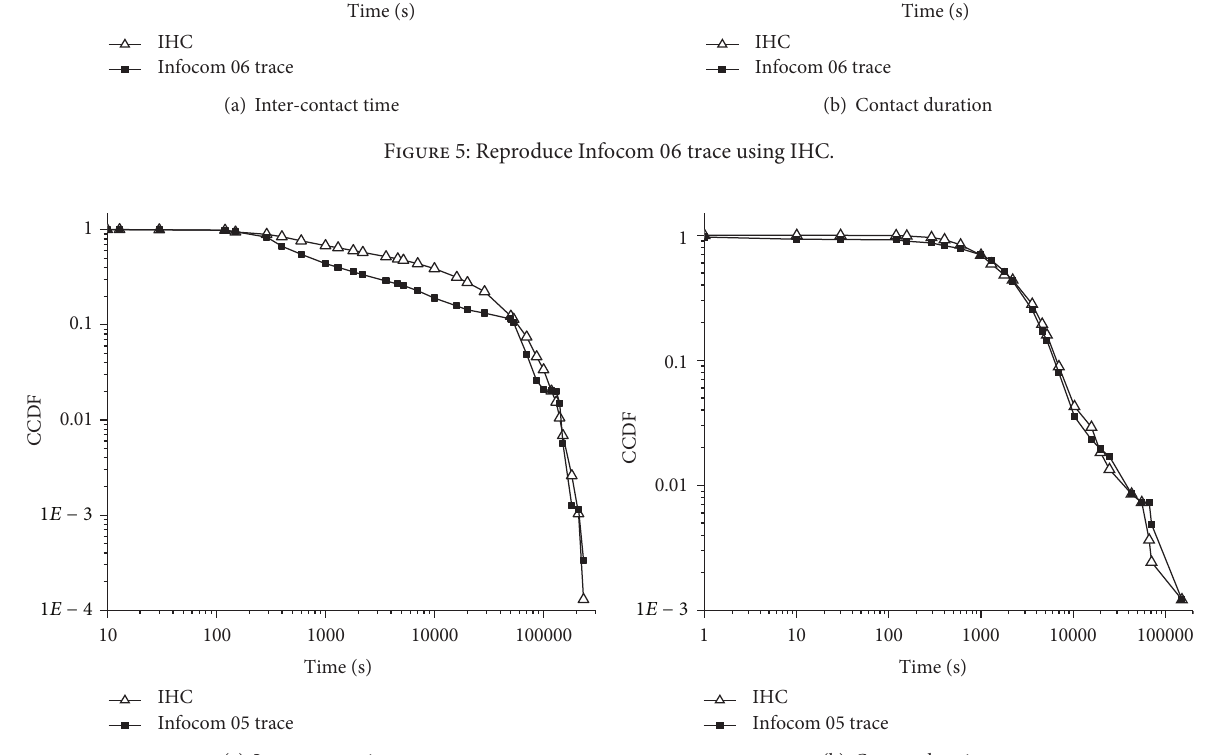
Figure 6: Reproduce Infocom 05 trace using